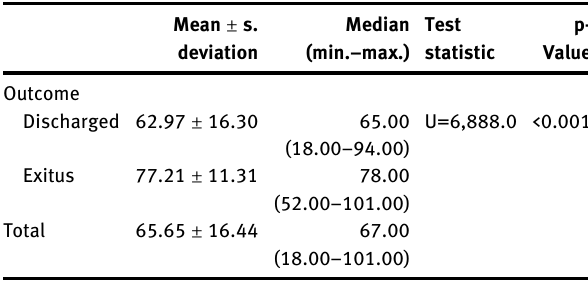
Table  : Comparison of the mean age of the patients according to the